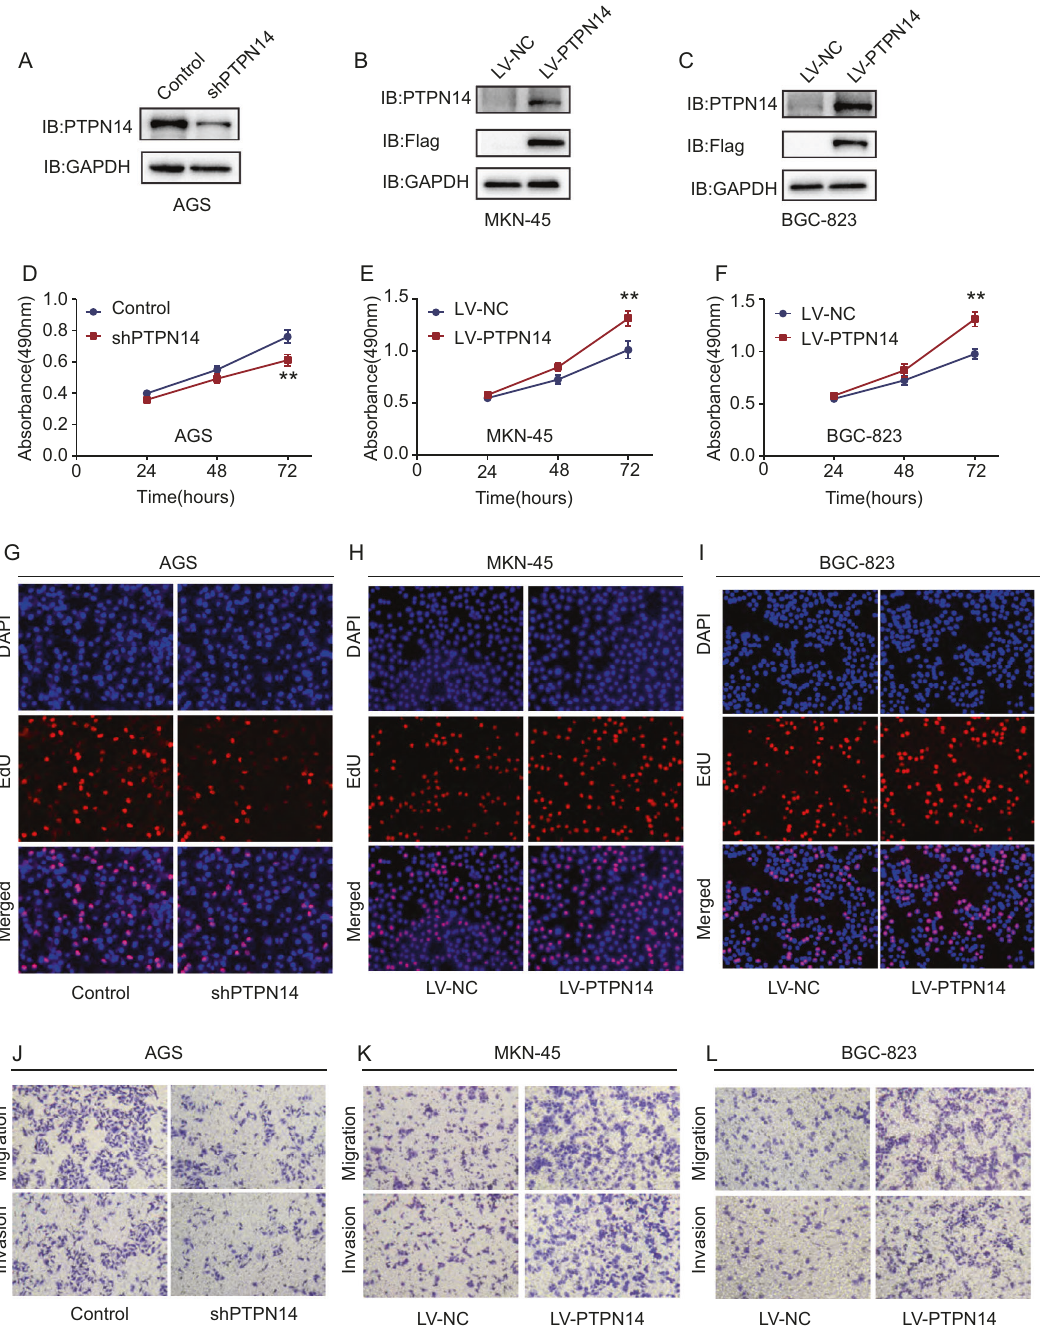
Fig. 3 PTPN14 promotes cell proliferation, migration, and invasion in vitro. A – C Western blot veri fi ed the overexpression or knockdown ef fi cacy of PTPN14. In AGS cells, PTPN14 expression was decreased by shRNA ( A ). In BGC-823 cells, LV-PTPN14 stably increased the expression of PTPN14 ( B ). In MKN-45 cells, LV-PTPN14 stably increased the expression of PTPN14 ( C ). D – F CCK-8 assays showed that PTPN14 knockdown inhibited cell proliferation in AGS cells ( D ), while overexpression of PTPN14 promoted cell proliferation in MKN-45 cells ( E ) and BGC-823 cells ( F ). ** p < 0.01; cells overexpressing PTPN14 or knockdown PTPN14 were compared with control cells. G – I EDU assays showed that PTPN14 promoted cell proliferation. In AGS cells, the shPTPN14 group showed fewer EDU-positive cells than the control group ( G ). The LV-PTPN14 group showed more EDU-positive cells than the control group in MKN-45 cells ( H ) and BGC-823 cells ( I ). J – L Transwell assays indicated that PTPN14 promoted gastric cancer cell migration and invasion. In AGS cells, the shPTPN14 group showed fewer migrating or invading cells than the control group ( J